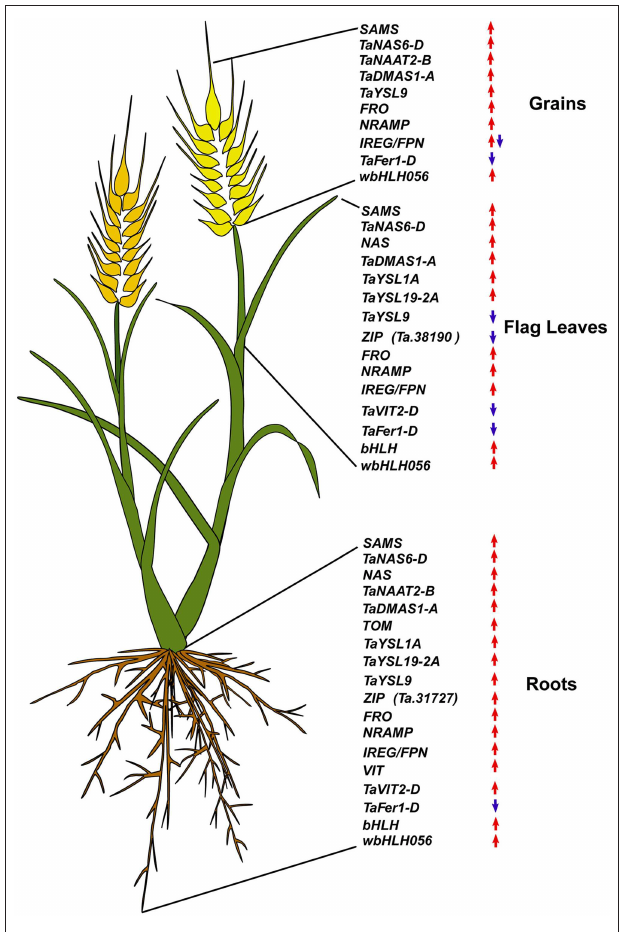
FIGURE 6 | Summary of the expression modulation of wheat iron homeostasis related genes. Upregulated genes are indicated by an upward red arrow and the downregulated ones are indicated by a downward blue